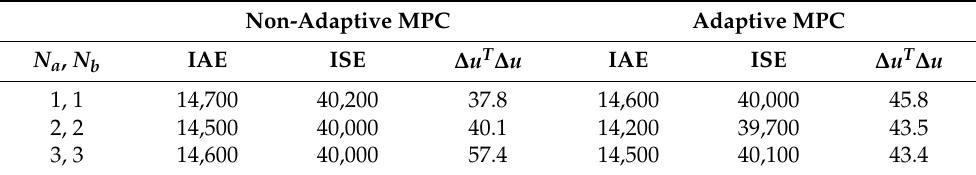
Table 5. The controller performance criteria for a step change in glucose setpoint (15 mM to 18 mM).